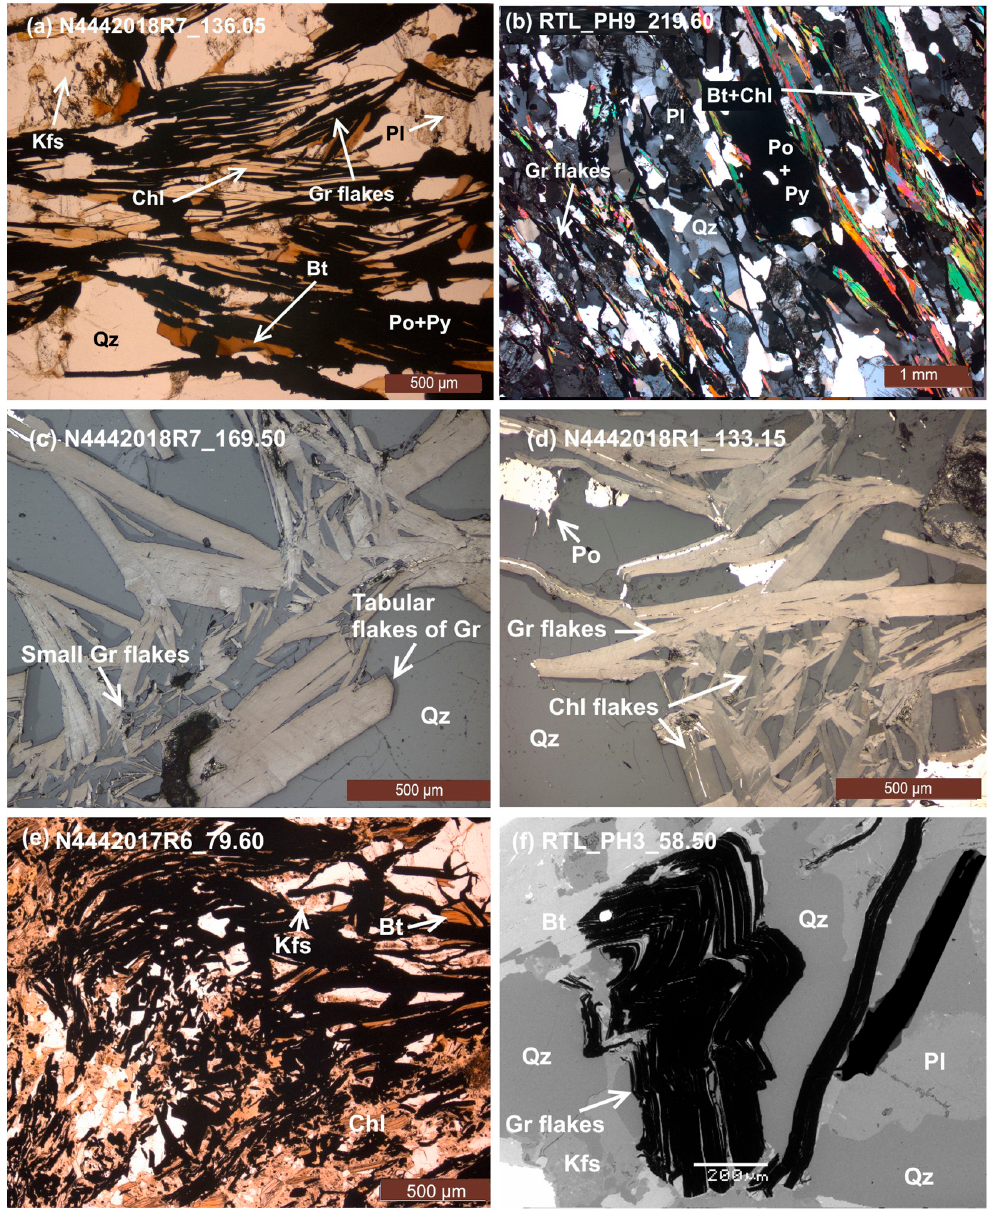
Figure 3. Petrography of a graphite-bearing schist and gneiss as seen in a polarization microscope. ( a , b ) The graphite flakes show strongly foliated schist consisting of alternating biotite, quartz, plagioclase, chlorite, and sulfide minerals; ( c , d ) reflected light image showing the large graphite flakes ( ≥ 1 mm) occurring as flat, plate-like crystals (>30 µm width), with angular and rounded edges; ( e ) plane-polarized light illustrating two graphite populations within one sample, coarse and fine graphite flakes; ( f ) selective graphite flakes as seen in SEM. Table 2. Chemical composition and normative mineralogy of the studied graphite ore (wt. %). Composition